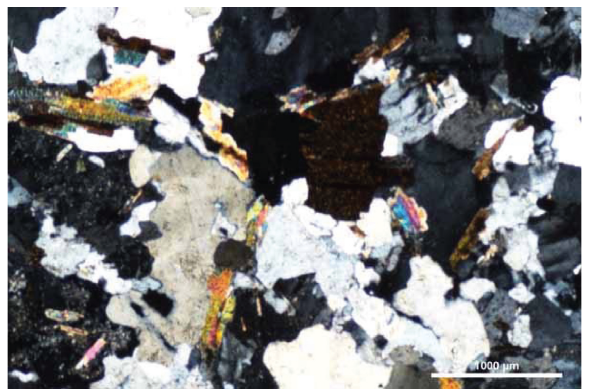
Figure 1: Minerals of the Sanshandao granite under the